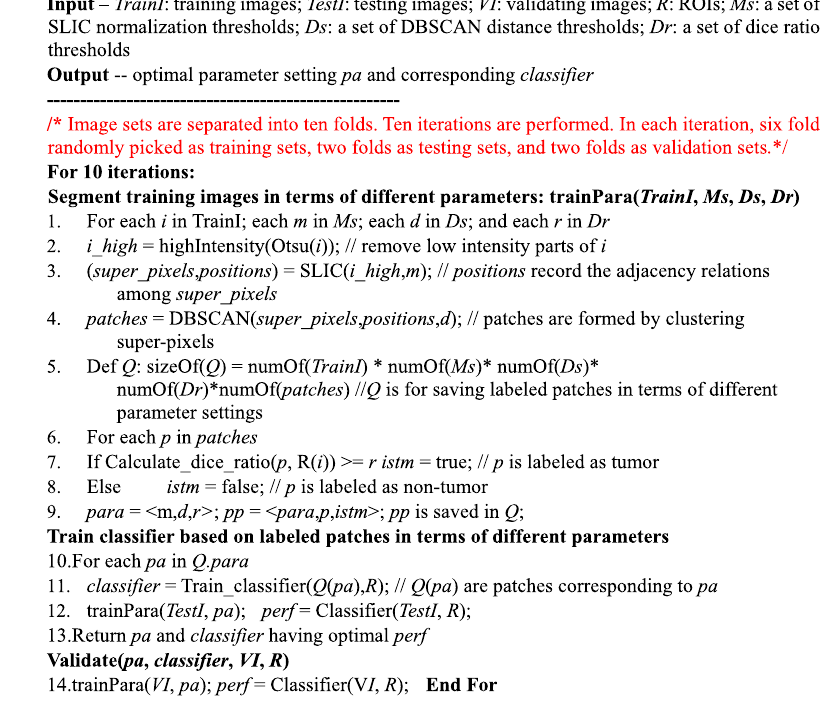
Fig. 5. Determination of optimal parameters for segmenting and classifying tumor